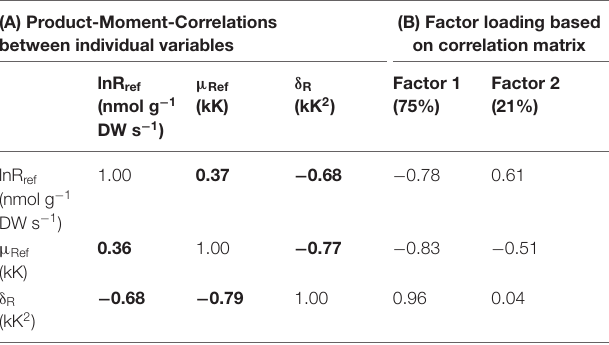
TABLE 5 | Extraction of two principal components from variation in three variables defining respiratory performance of Eucalyptus